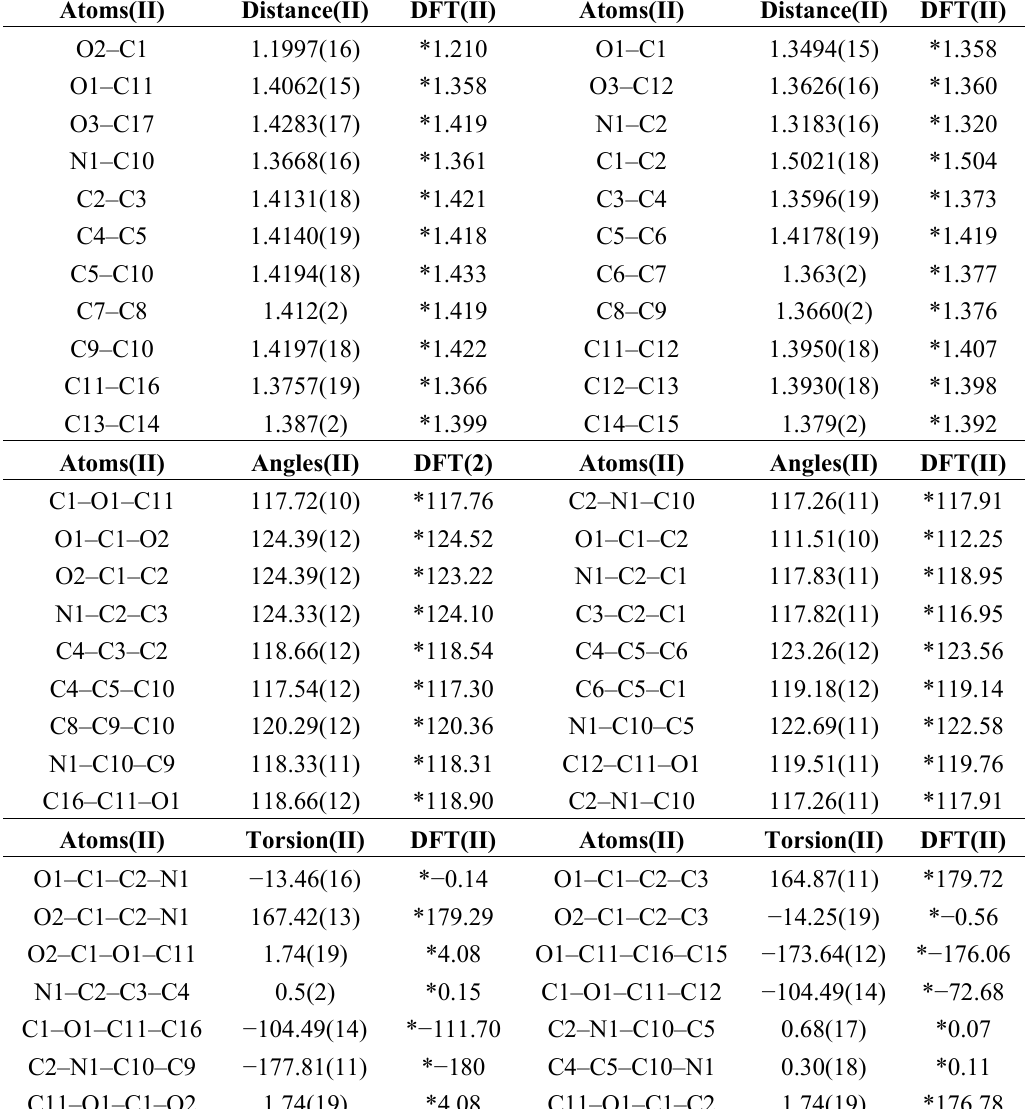
Table 3. Selected crystal and DFT* bond lengths (Å), bond angles (°), and torsion angles (°) for (II) , C H NO . 17 13 3